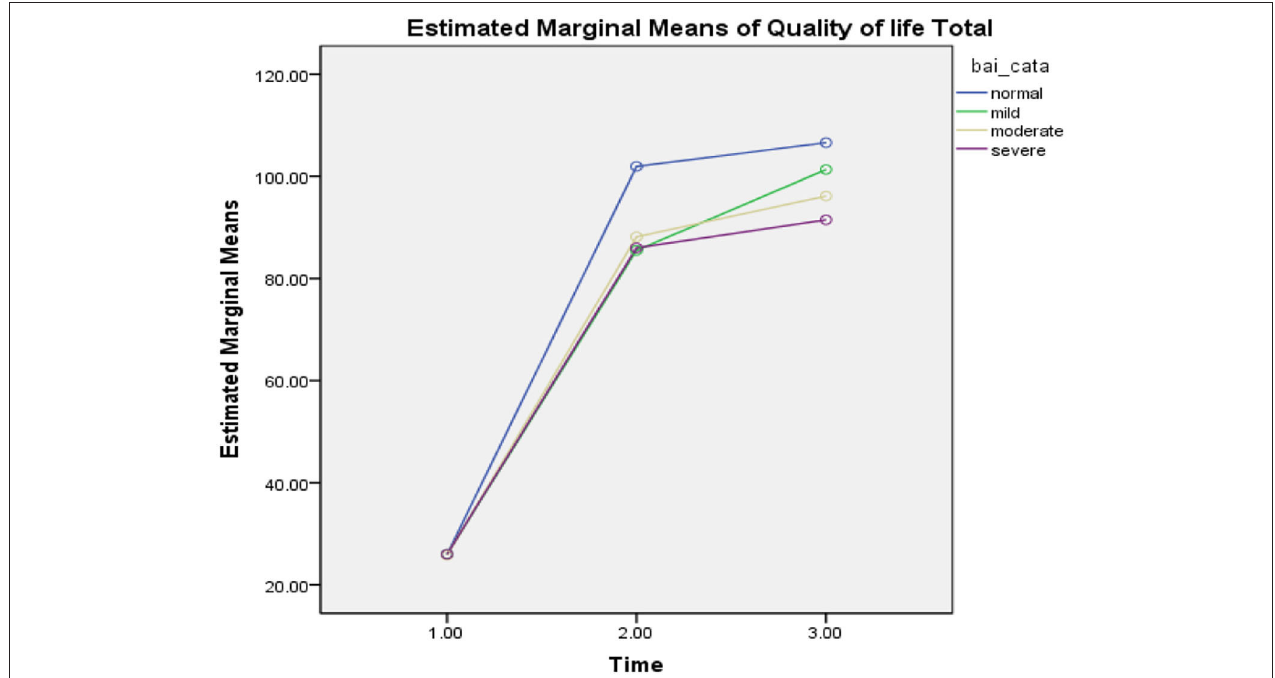
FIGURE 3 | Mean difference of quality of life between T-0 (pretesting phase), T-1 (posttesting phase), and T-2 (follow-up phase) with different levels of anxiety in Pakistan students during the COVID-19 epidemic lockdown ( N = 40). Time, three phases; bai_cata, severity level of anxiety; quality of life total, quality of life.